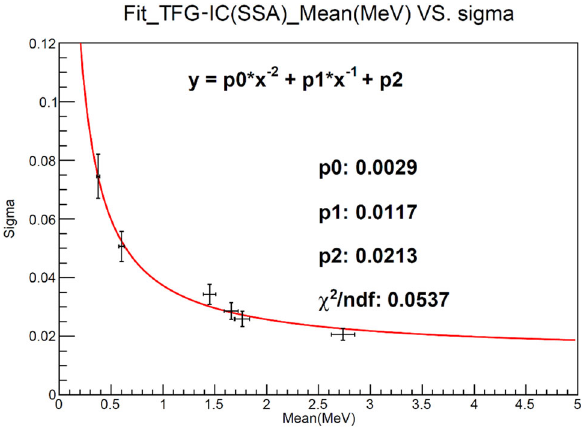
Fig. 11 Fitted extrapolated ionization chamber at different gas pres- suresmeasuredenergyandenergyresolved.Thefirstfourpointsandthe last two points are obtained using the P10 and CF 4 gases, respectively